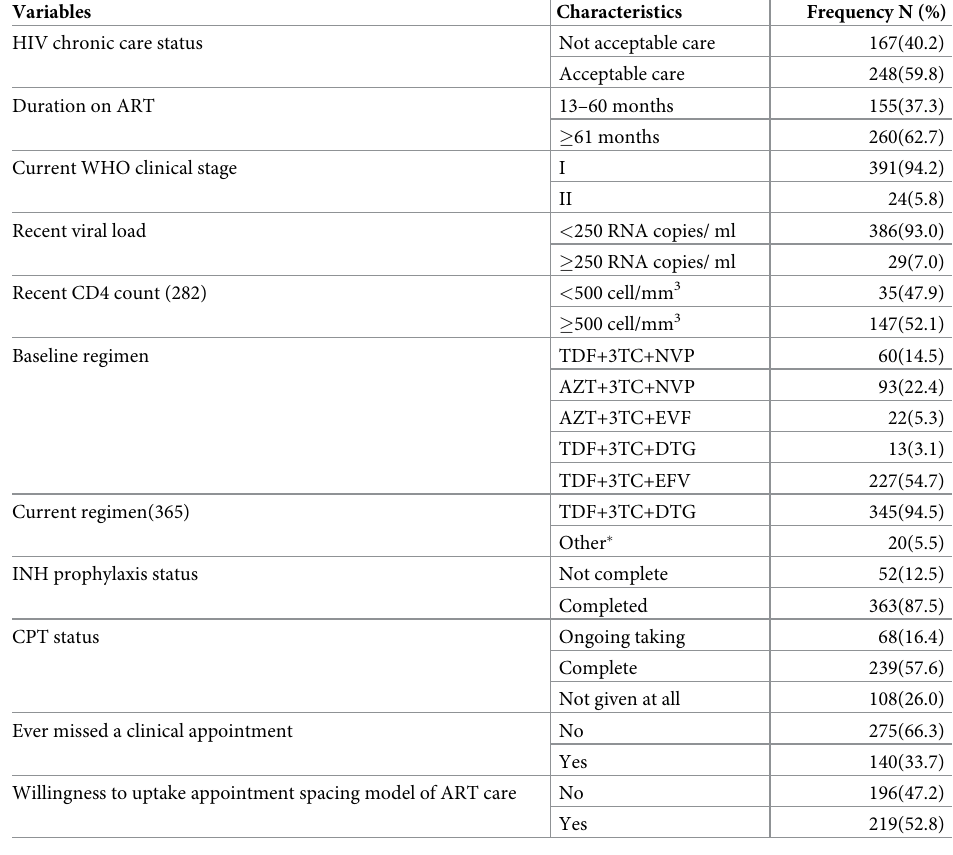
Table 3. Clinical care-related factors of uptake ASM among stable clients on antiretroviral therapy in East Gojjam Zone, Amhara, Northwest Ethiopia, 2020 (n =